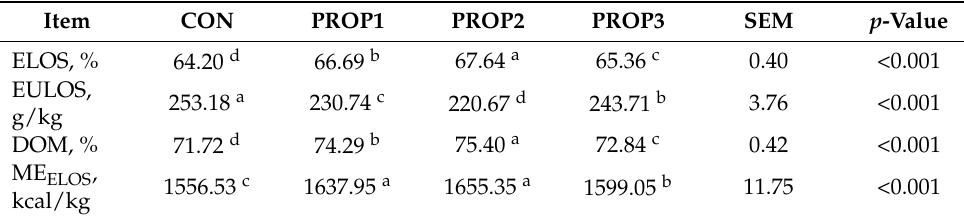
Table 10. Pearson correlations between main quality criteria in silages. Variable